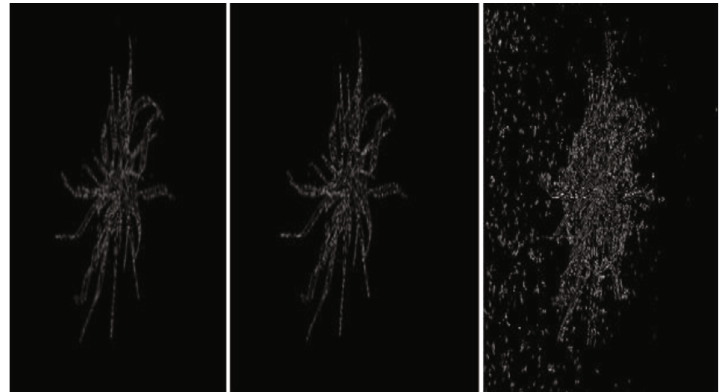
Figure 8: Segmentation algorithm used: convolution gradient fi lters (Sobel, Prewitt, Canny); description: nonsmooth edges for all the three operators.